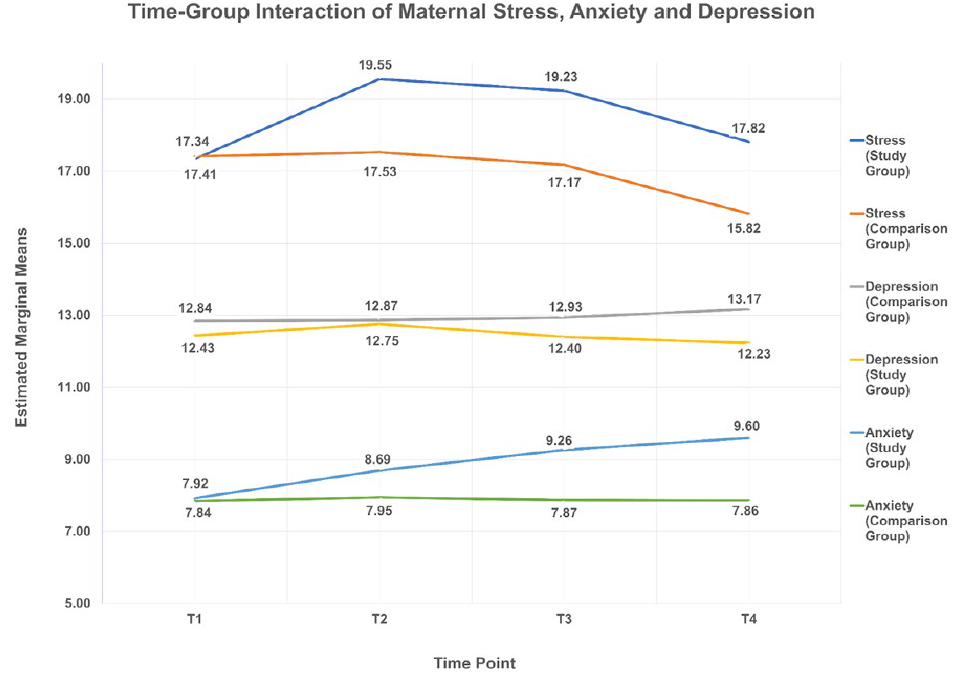
Figure 2. Time–group interaction of maternal stress, anxiety, and depression. Note: (1) A stress score between 14 and 26 indicates moderate stress, (2) An anxiety score between 0 and 7 and between 8 and 10 indicate low and moderate levels of anxiety, respectively, (3) A depression score between 11 and 21 indicate high levels of depression.